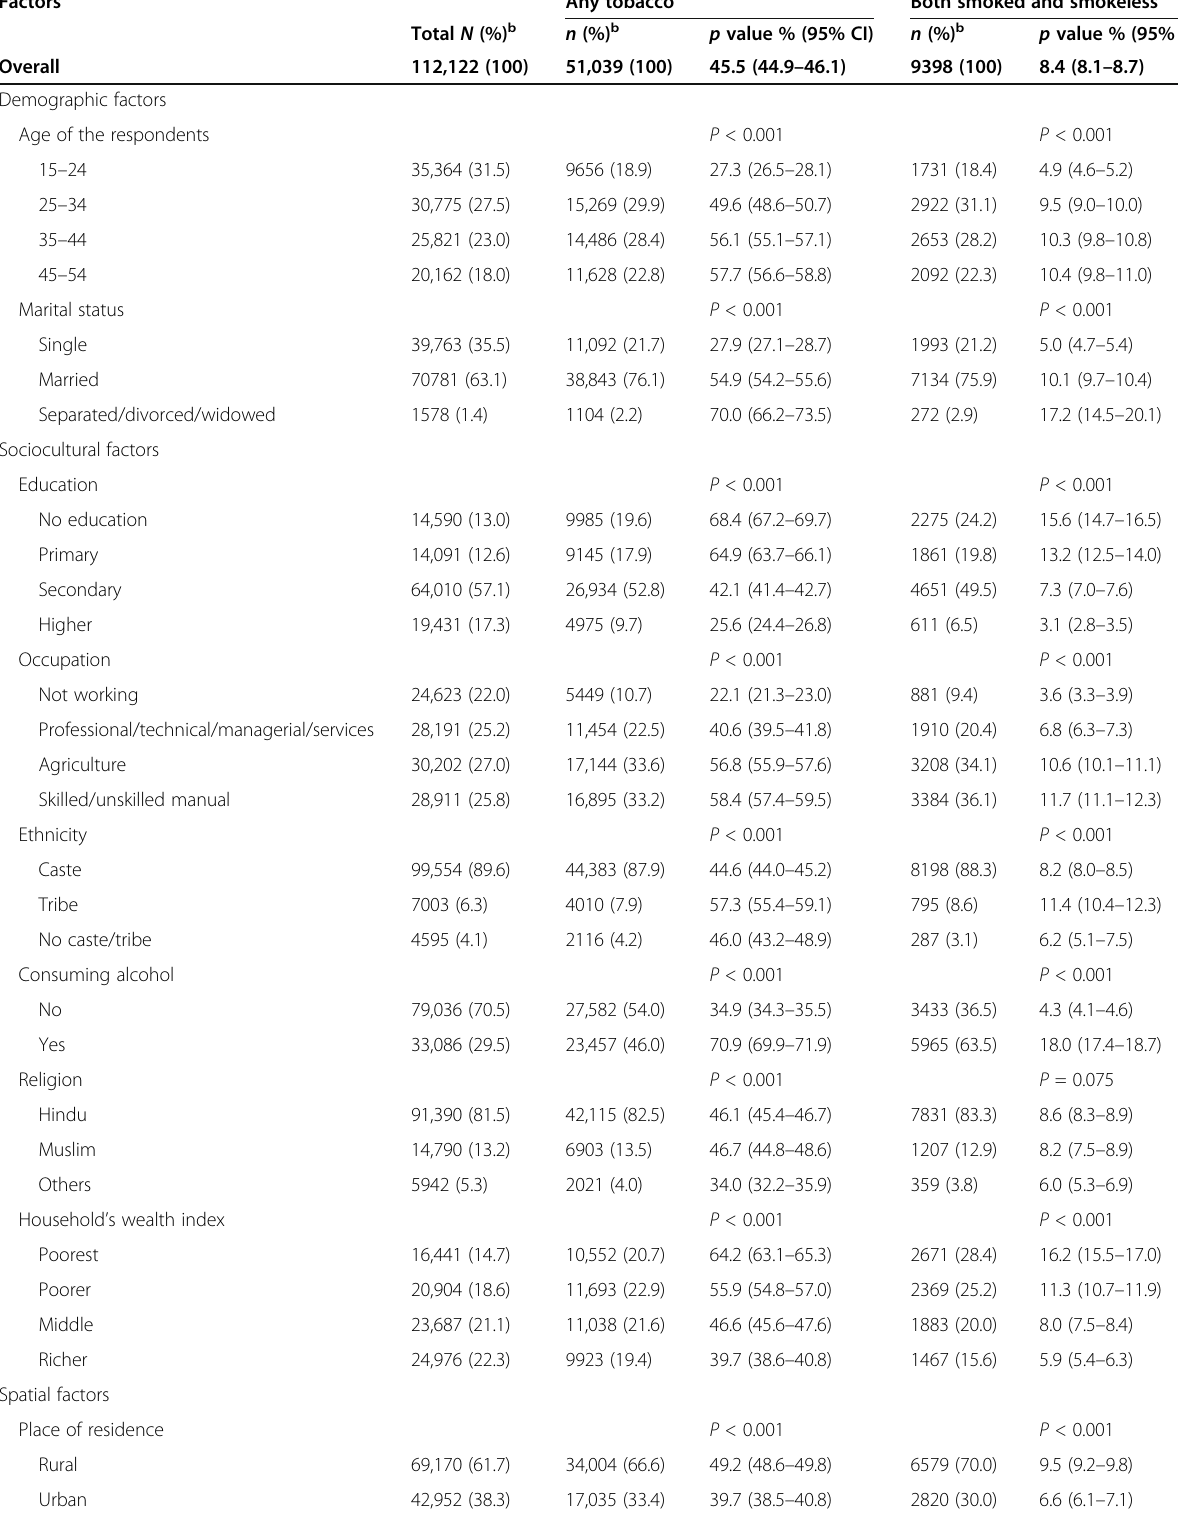
Table 2 Characteristics of the study population and prevalence of any tobacco and both smoked and smokeless tobacco use among Indian men by socio-demographic characteristics, India 2015 – 2016